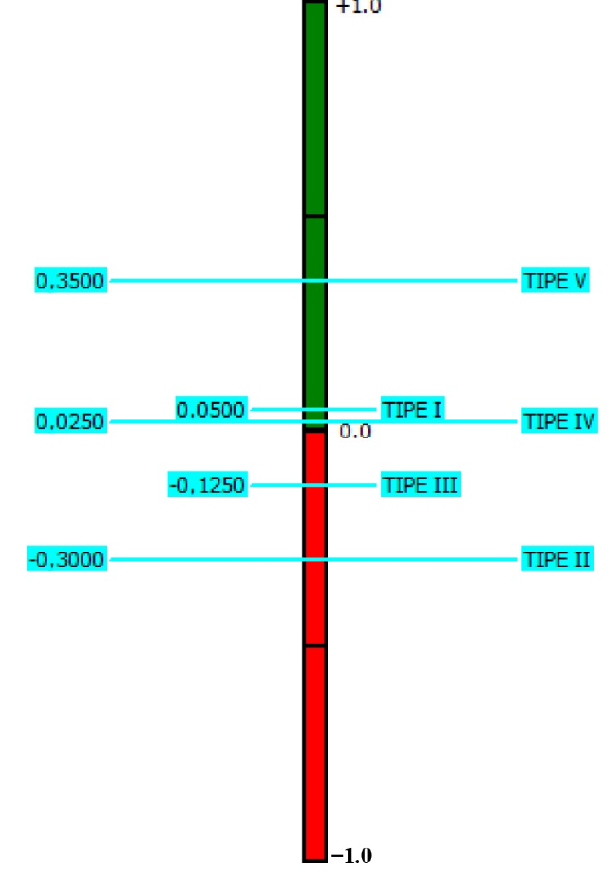
Figure 4. Promethee ranking for community-based village development strategy in Cigalontang District, Tasikamlaya Regency.